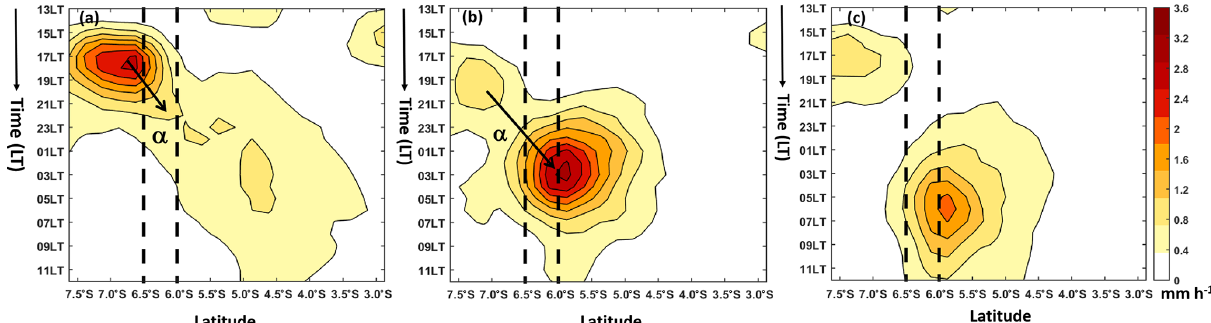
Figure 5. Hovmöller diagrams of composite diurnal precipitation, similar to Fig. 2 except that data are classified by the phases or the timing of peak precipitation (as in Fig. 3) (a) AEP, (b) EMP, and (c) LMP. The black-dashed line indicates the boundary of the coastal area. The black solid arrows represent the direction of propagation (following Mori et al., 2004), with seaward propagation symbolized by α and landward propagation indicated by β .